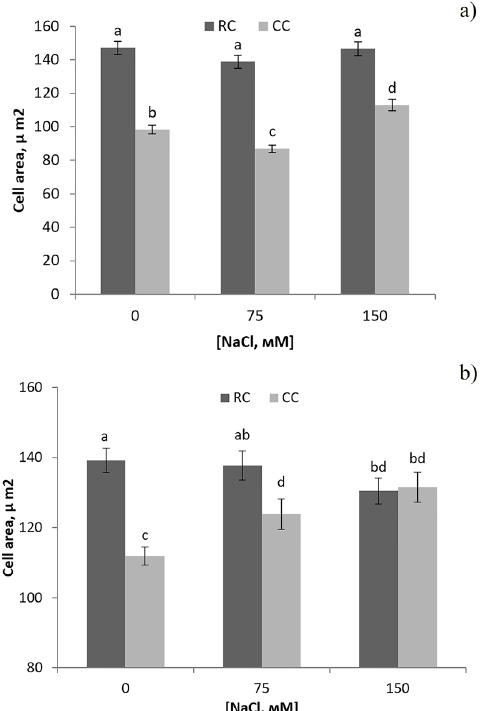
Figure 5. The effect of different NaCl concentrations in the nutrient medium for the induction of rhizogenesis on the cell area of the YaLF tomato line ( a ) and cv Recordsmen ( b ) as shown by light microscopy. Abbreviations: RC—root cortex cell; CC—central cylinder cell. Means followed by the same letter are not significantly different at α = 0.05 according to Duncan’s multiple range test.